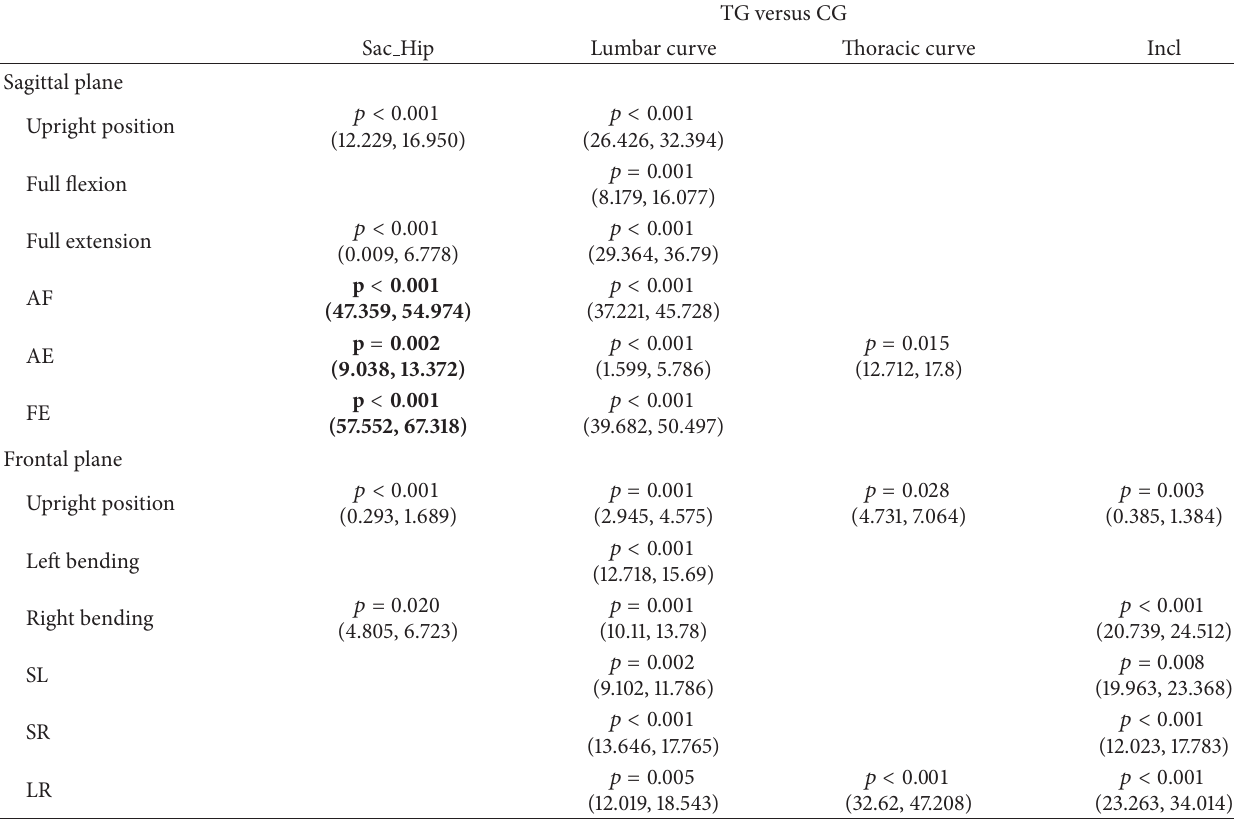
Table 5: Statistically significant differences between the CG and TG, based on the measurements of Spinal Mouse ( 𝑝 value and CI